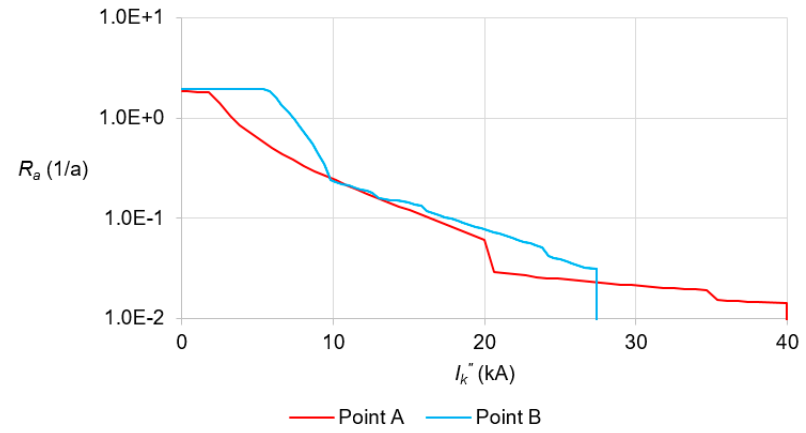
Figure 10. Expected annual frequency of exceeding actual values of short circuit current at inspection points A and B on substation bus bar.